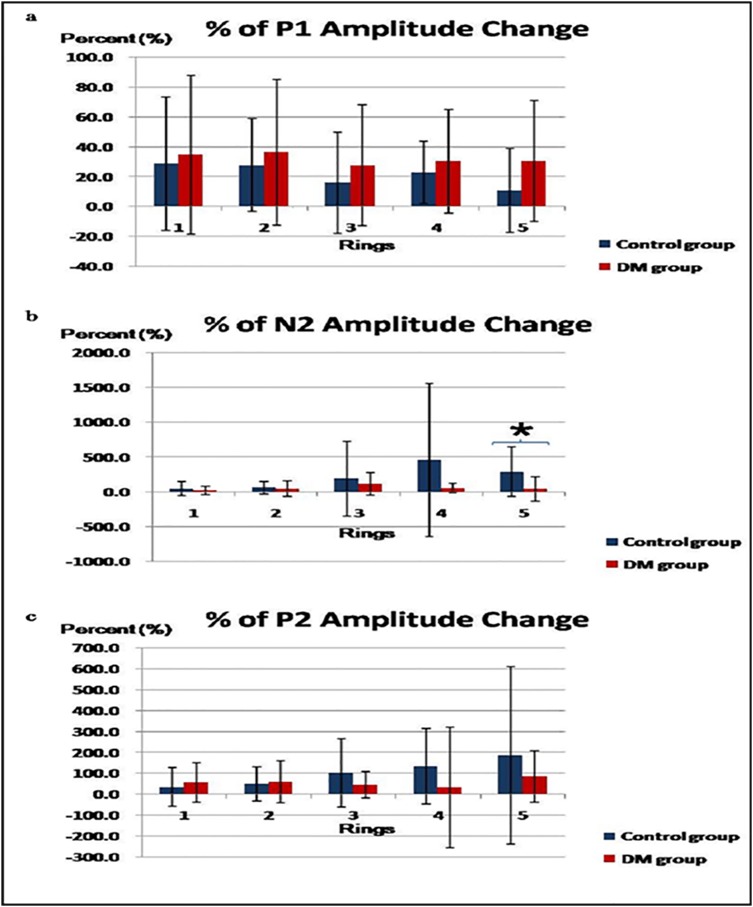
(a) The amplitude changes (in percentage) of the P1 amplitude (mean ± SD) due to the change from white to blue stimulus between the control and the diabetic groups; (b) The amplitude changes (in percentage) of the N2 amplitude (mean ± SD) due to the change from white to blue stimulus between the control and the diabetic groups; (c) The amplitude changes (in percentage) of the P2 amplitude (mean ± SD) due to the change from white to blue stimulus between the control and the diabetic groups (* indicates parameters that achieved statistically significant level with p < 0.05)